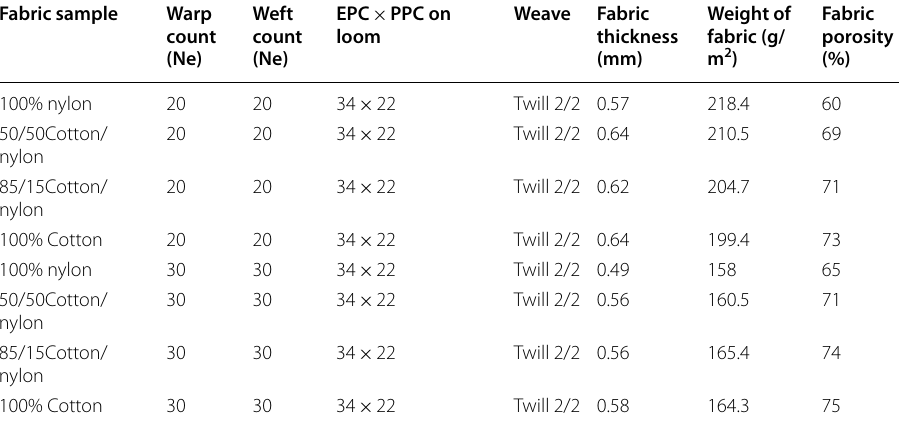
Table 2 Specifications of the different woven fabrics Fabric